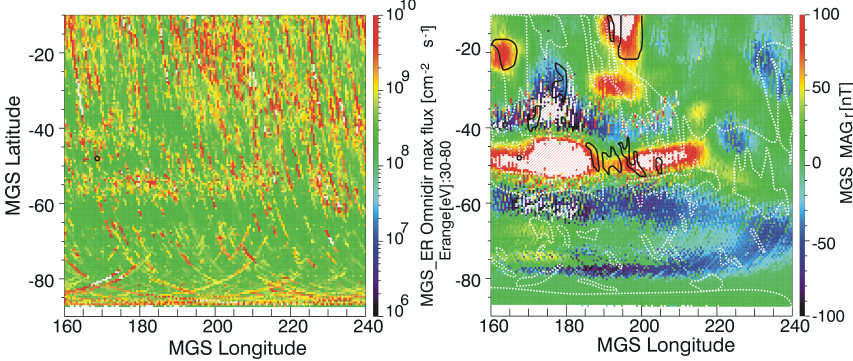
Fig. 4. (a) Precipitation pattern of electrons at 400km from the MGS observations; (b) Map of the vertical component B r of the crustal field based on the results by Connerney et al. (2001). Regions of enhanced precipitation are bounded by dotted white curves and solid black curves. A black circle at Lat =− 48 ◦ , Long = 167 . 5 ◦ corresponds to the foot of cusp detected on 7 July 2007.